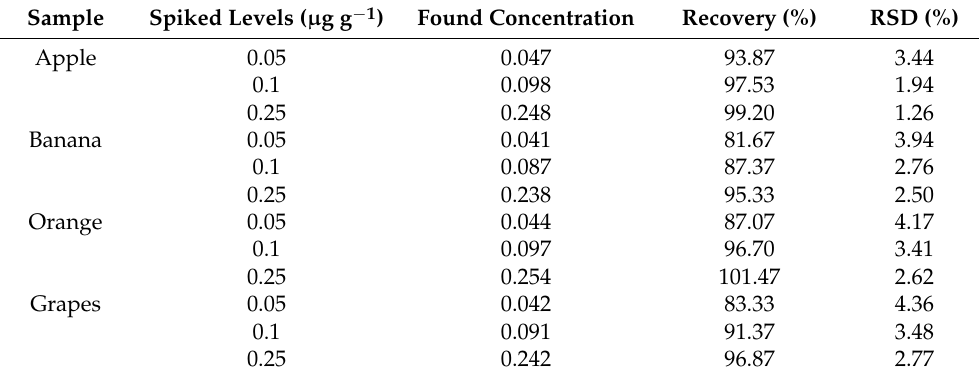
Table 5. Determination of ABM in fruit samples.